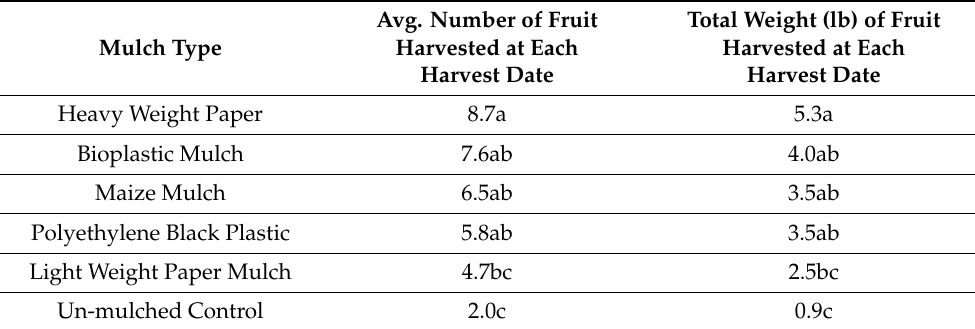
Table 4. Cucumber yield as influenced by mulch treatments in the 2020 Louisiana and Mississippi biodegradable mulch trials, both states